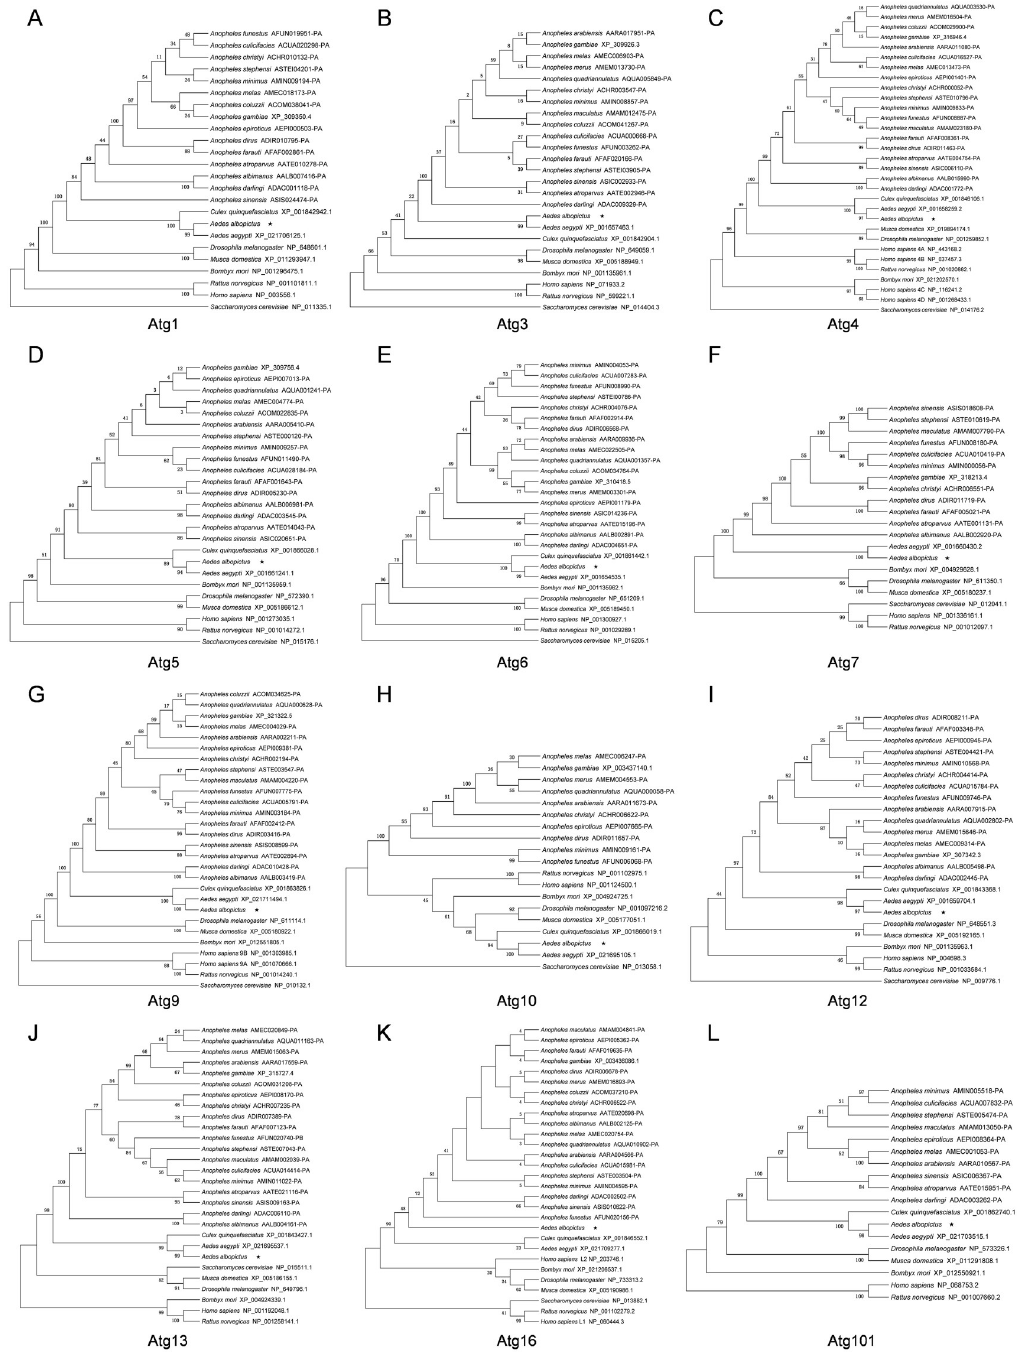
Fig 2. Phylogenetic analysis of AaAtg proteins. (A)—(L) The phylogenetic trees were constructed by MEGA 5.2 using the neighbor-joining method and 1000 bootstrap replicates. Multiple sequence alignments were performed using sequences of Atg orthologous from Saccharomyces cerevisiae , Homo sapiens , Rattus norvegicus , Drosophila melanogaster , Musca domestica , Bombyx mori and mosquitoes ( Aedes , Anopheles , Culex ). The sequences of AaAtg proteins of Aedes albopictus were indicated by a pentacle.